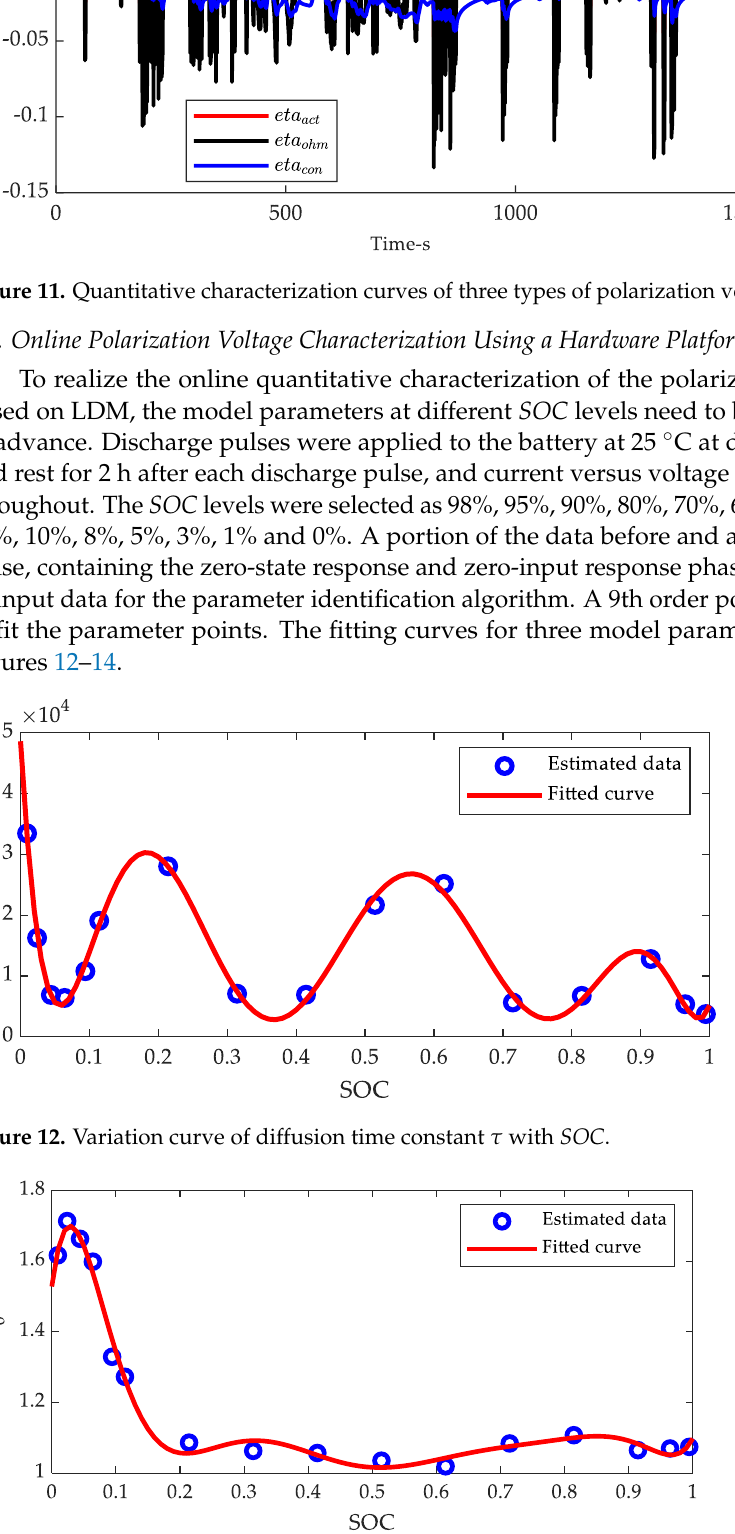
Figure 10. Variation curve of SOC on the surface of electrode particles with time.